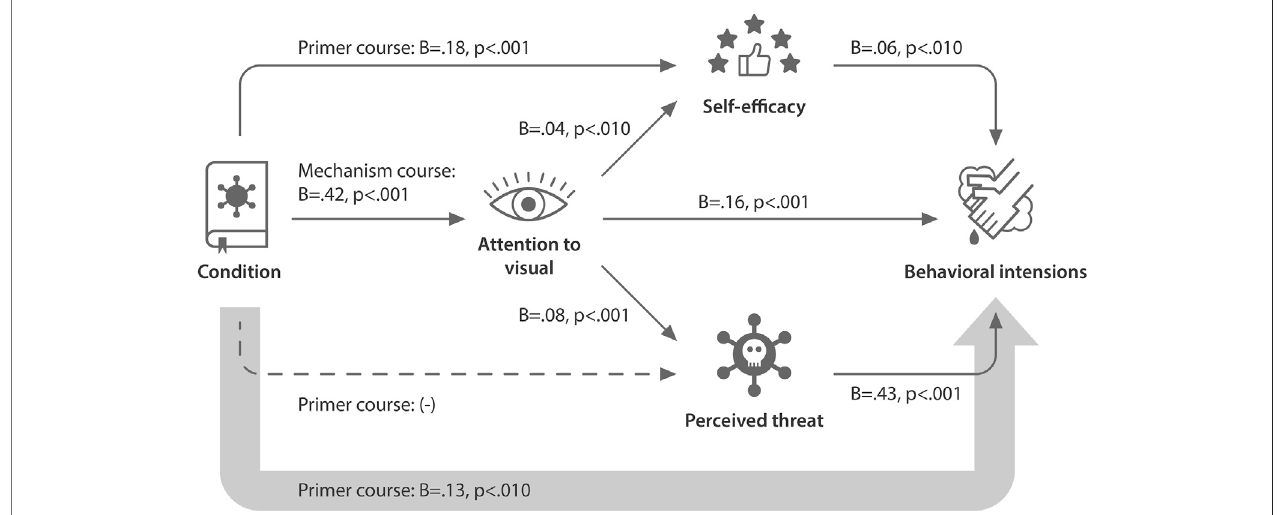
FIGURE 3 | Path diagram illustrating the relative direct and indirect effects of illustrated fl ashcard course viewing on behavioral intentions toward COVID-19. This path diagram visually represents aserial mediation modelofthe effects ofviewing three differentcourses on behavioral intentionsvia attention tothe course visuals, self- ef fi cacy, and perceived threat. Solid thin arrows represent signi fi cant links between variables ( p < 0.01), dashed thin arrows represent marginally signi fi cant links ( p < 0.05). B, unstandardized coef fi cients showing relationship between variables. The larger arrow connecting condition directly to behavioral intentions denotes the path from predictor to outcome controlling for all mediators. See Table 3 for full results of the regression analyses that this path diagram represents.